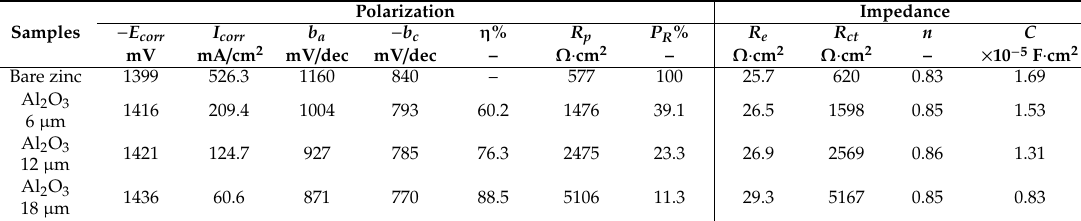
Figure 5. The polarization curves obtained for the bare and different thicknesses of Al 2 O 3 -coated zinc substrates in 4 M KOH solutions ( a ). Plots of the porosity as a function of the coating thicknesses calculated from Equation (4) ( ◼ ) and SEM ( ⚫ ) ( b ). Table 1. Corrosion parameters from polarization curves and electrochemical impedance spectroscopy (EIS) fitting parameters form Nyquist plots.